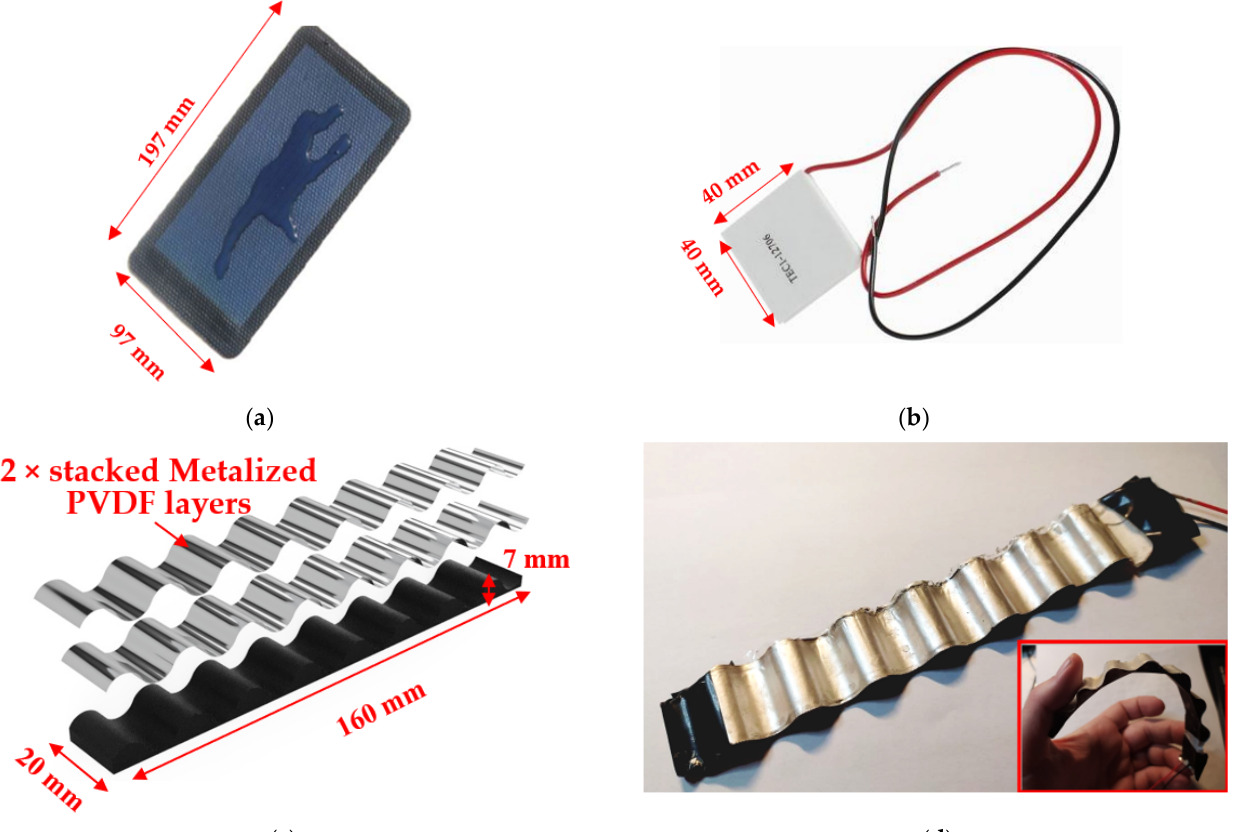
Figure 4. Flexible solar panel ( a ) and TEG device ( b ) integrated into the garment; 3D model ( c ) and photo of realized corrugated piezoelectric transducers for gathering energy from joint motions (placed outside the garment for higher clarity ( d ).